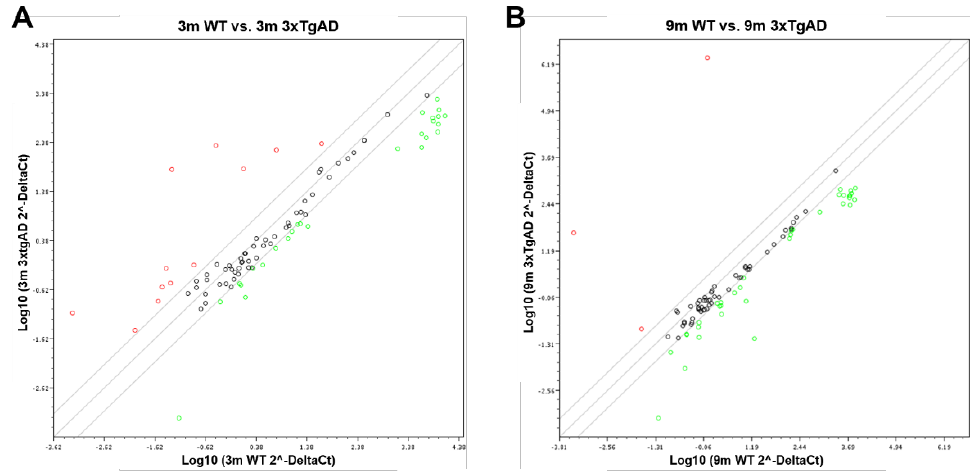
Figure 9. Scatter plot representation of the expression of miR-155 targets in 3xTg-AD vs. wild-type (WT) mice. RNA was isolated from cortical brain samples of WT and 3xTg-AD animals at 3- ( A ) and 9-month-old ( B ) and analyzed for the expression of miR-155 target genes by RT-qPCR. Results are expressed as Log10 gene expression from a pool of n = 4 animals per experimental group. Table 3. Expression of miR-155 target genes in cortical samples from 3-month-old 3xTg-AD mice vs. respective wild-type (WT) animals.